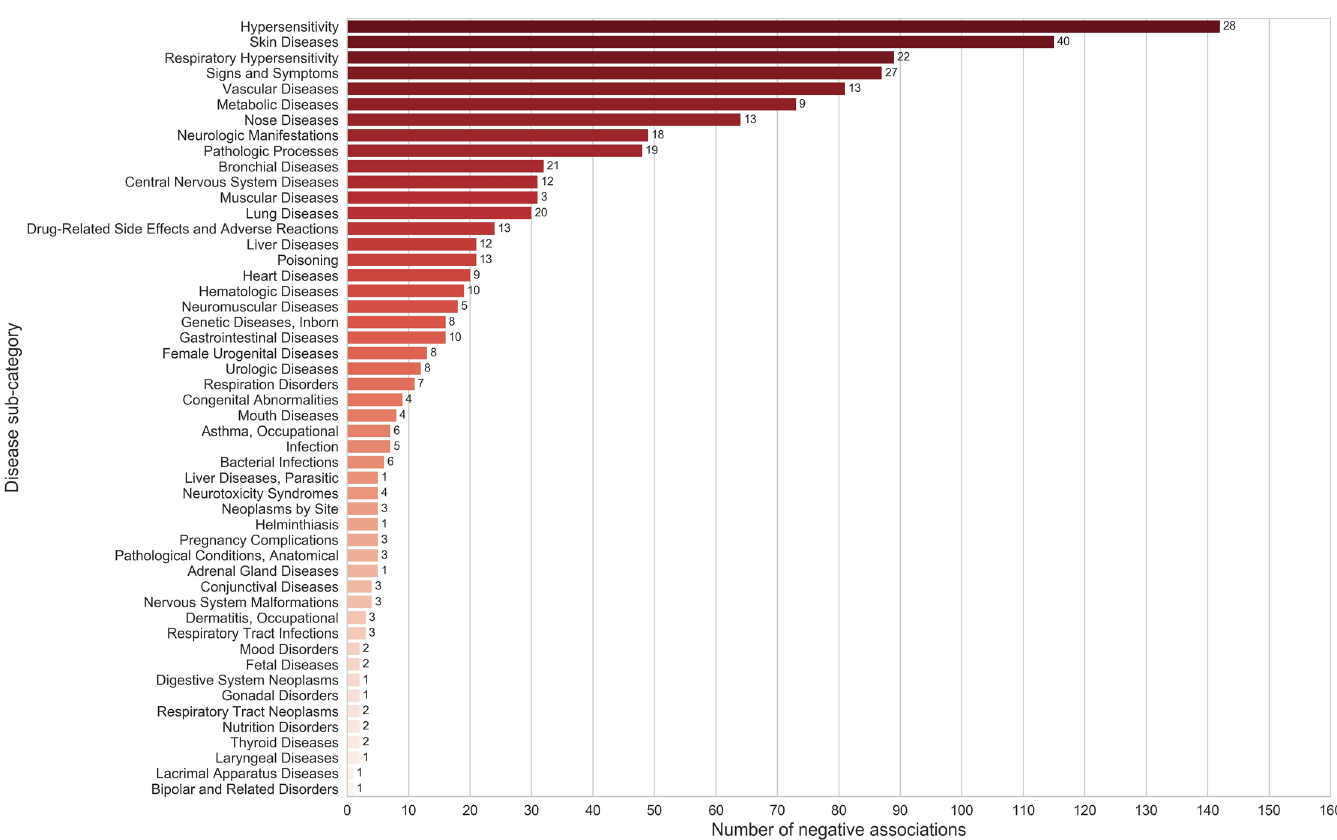
Fig 7. Disease categories (First level of MeSH hierarchy) ranked according to the number of negative associations with spices. Numbers shown against the bars indicate the ‘number of spices’ linked with each of the associations.